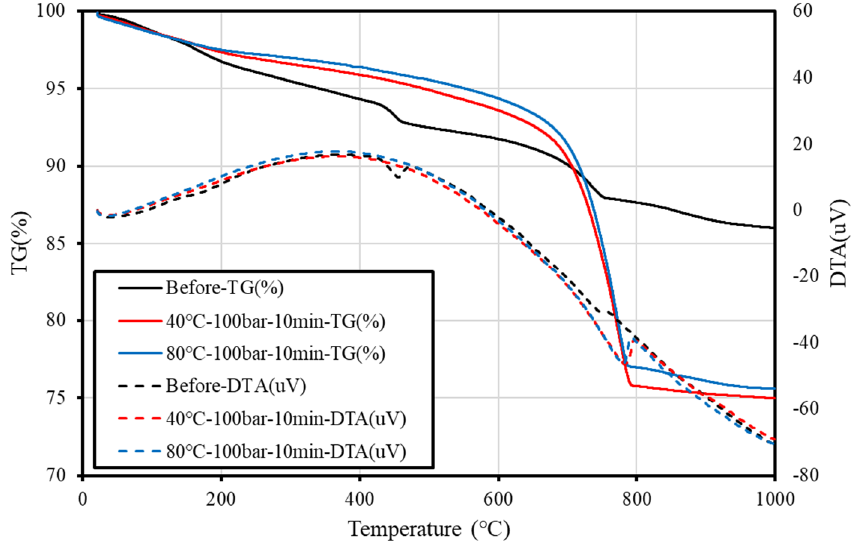
Figure 9. TG-DTA results obtained before and after supercritical CO 2 carbonation. Table 3. The amount of Ca(OH) 2 and CaCO 3 before and after supercritical CO 2 carbonation.